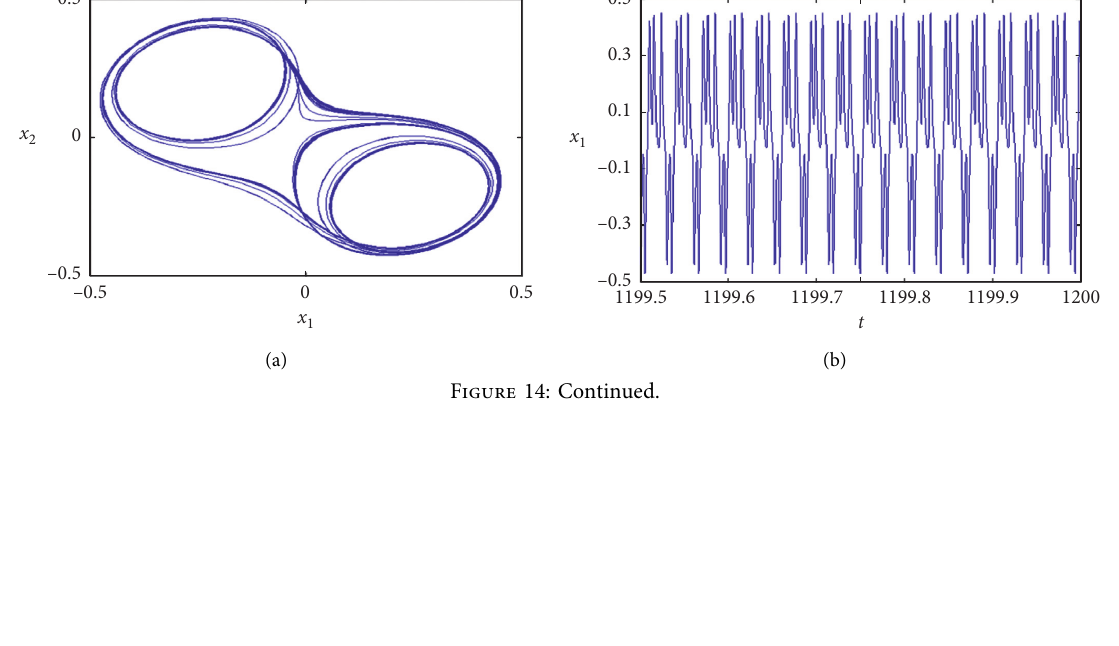
,x ) , (d) waveform 3 4 , x ) 1 2